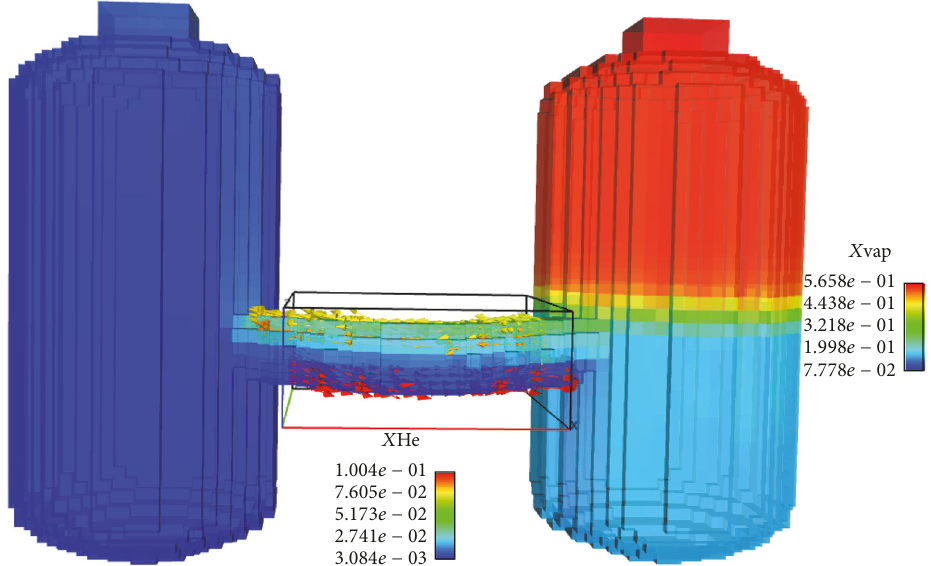
Figure 25: Vapor concentration in ST3 2 at 𝑡 = 4000 s; helium concentration is projected onto gas velocity in the